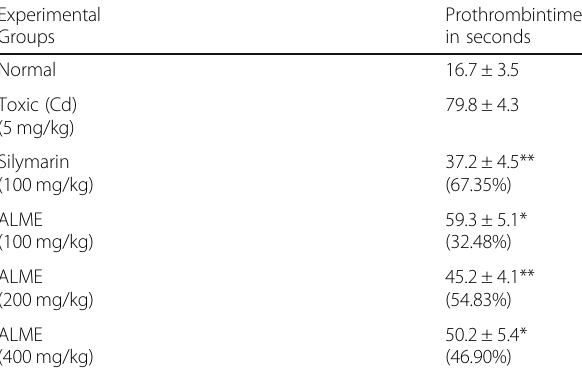
Table 5 Effect of ALME on Prothrombin time (seconds) in cadmium intoxicated rats Experimental Groups